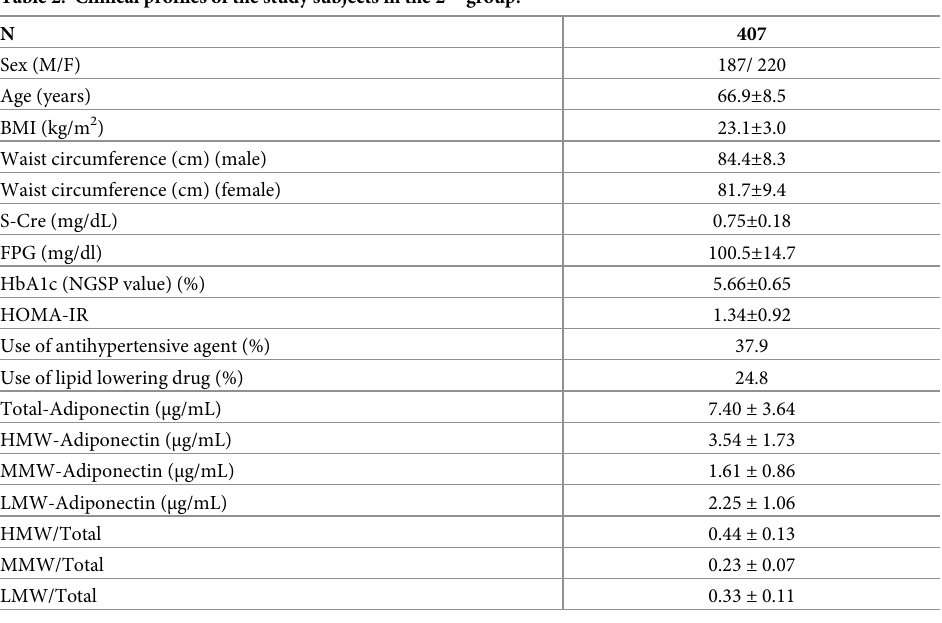
Table 2. Clinical profiles of the study subjects in the 2 nd